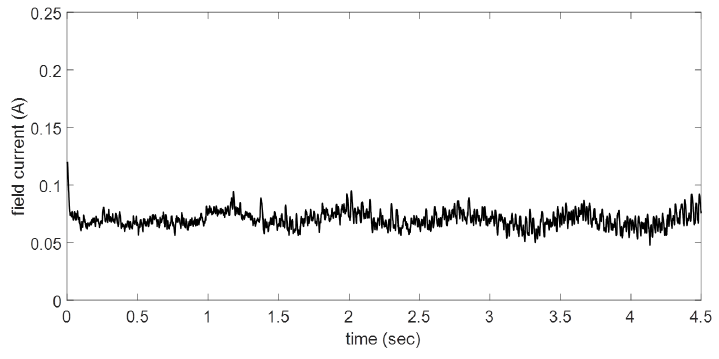
Figure 13. Field current evolution, case d